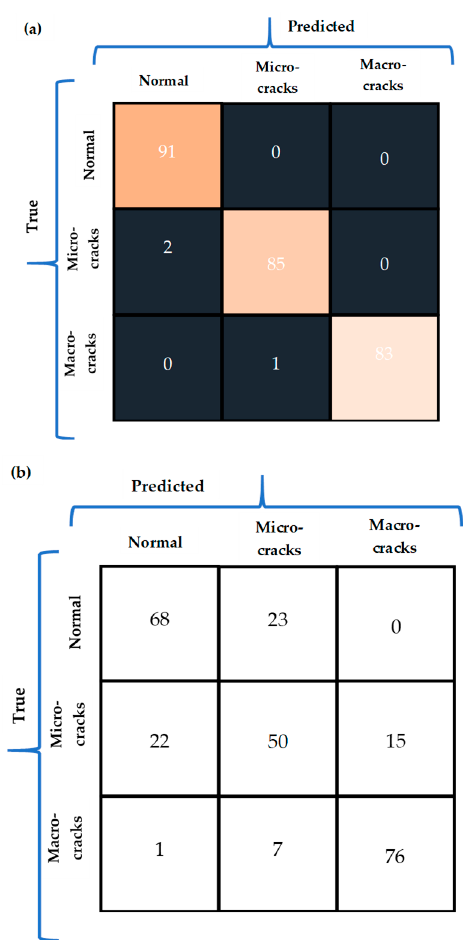
Figure 15. Confusion matrix: ( a ) k-NN and CAI plot and ( b ) k-NN and selected AE features. Table 2. Performance comparison of the different approaches. K-NN: k-nearest neighbor, CAI: crack assessment indicator, and AE: acoustic emission.